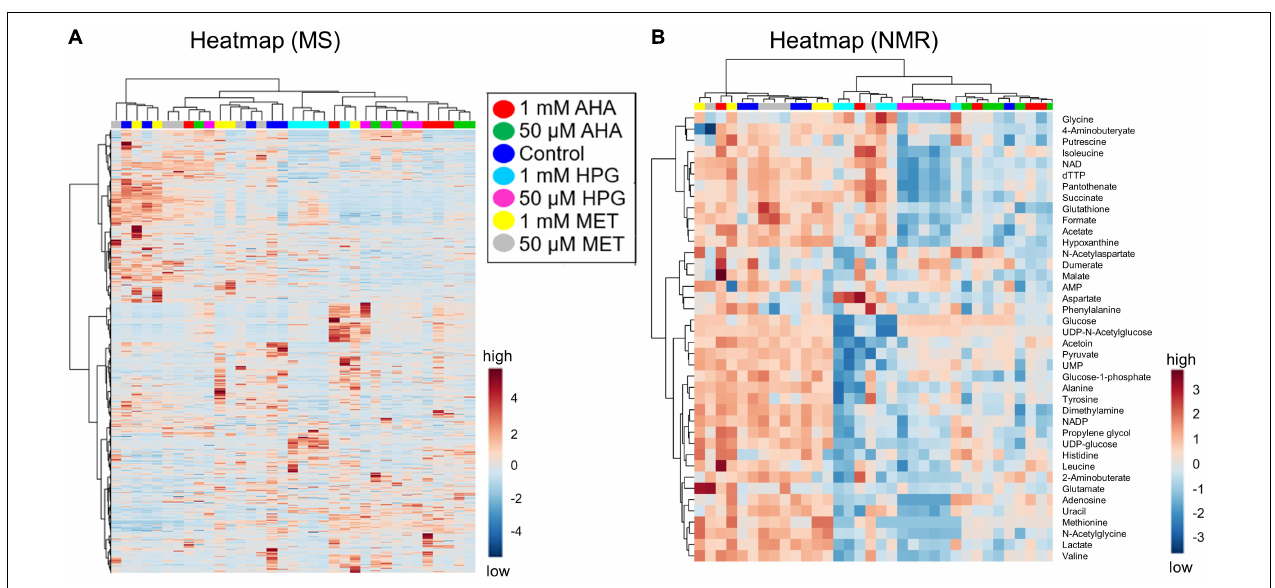
NMR-based metabolite profiles and concentrations ( Figure 1B